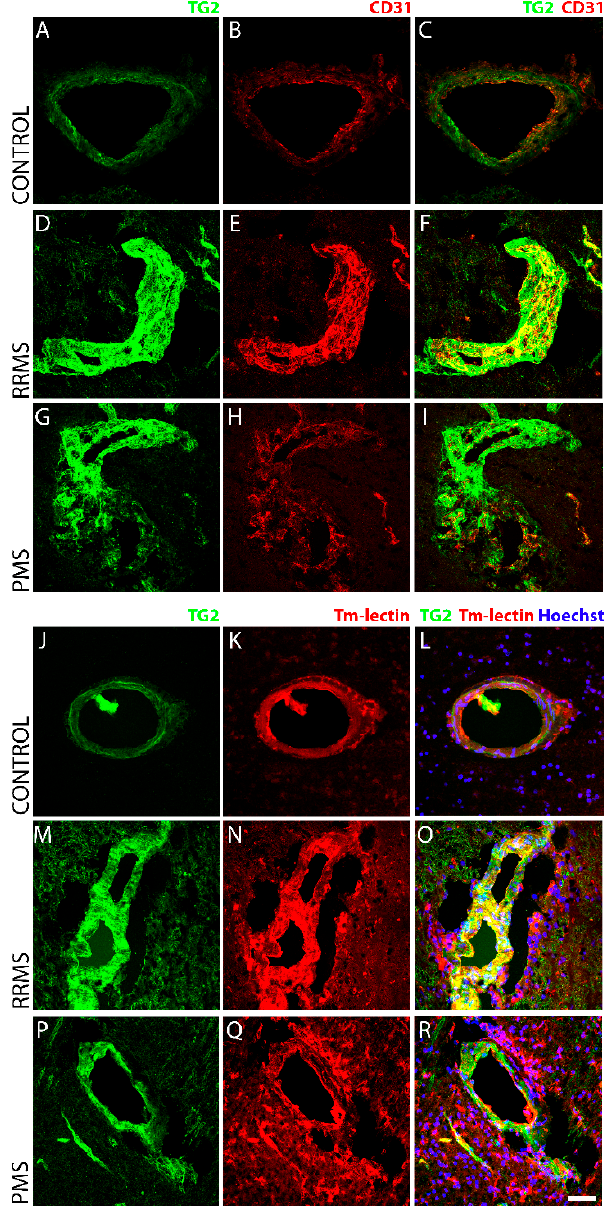
Figure 4. TG2 immunoreactivity is robustly upregulated in endothelial cells within active lesions of MS brain tissue. Compared to non-MS brain tissue (Top panel; A – C and Bottom panel; J – L ), which showed low levels of basal TG2 expression ( A , C , J , L ) in the endothelial cells labelled with CD31 (Top panel, B , E , H ) or tomato lectin (Bottom panel, K , N , Q ), TG2 expression was robustly increased in the active lesions of both forms of MS; RRMS (Top panel D , F and Bottom panel M , O ) and PMS (Top panel, G , I and Bottom panel P , R ). Scale bar = 50 µ